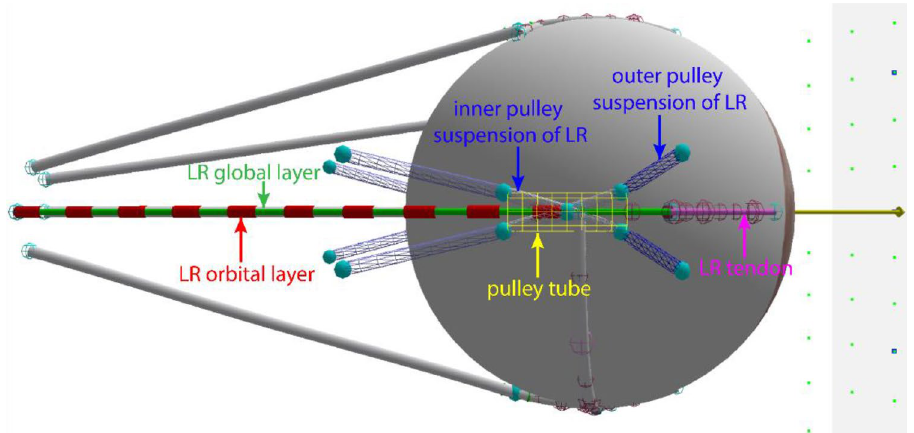
Figure 5. A lateral view of the new pulley model. The global layer and orbital layer of the lateral extraocular muscle are modeled as two separate muscle strands, as also implemented for the two layers of the medial rectus muscle that is not seen in this view. A pulley tube system was developed to model active pulley mechanics. LR: lateral rectus